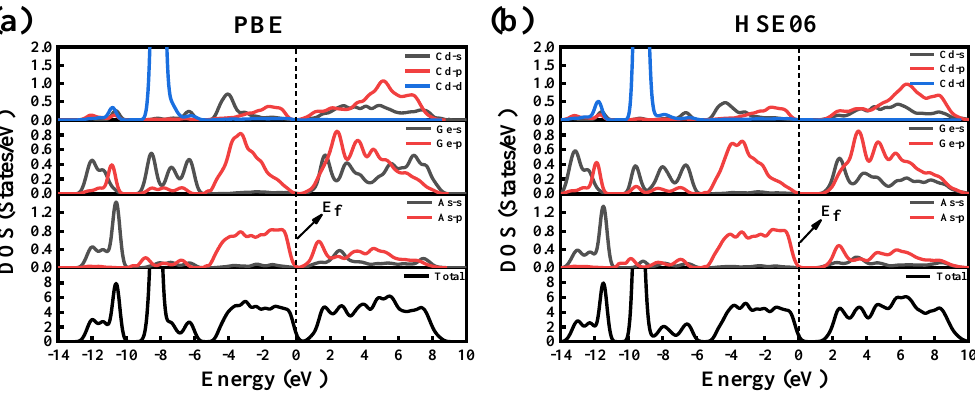
Figure 3. The total and partial density of states of CdGeAs 2 . ( a ) GGA–PBE, ( b ) HSE06.